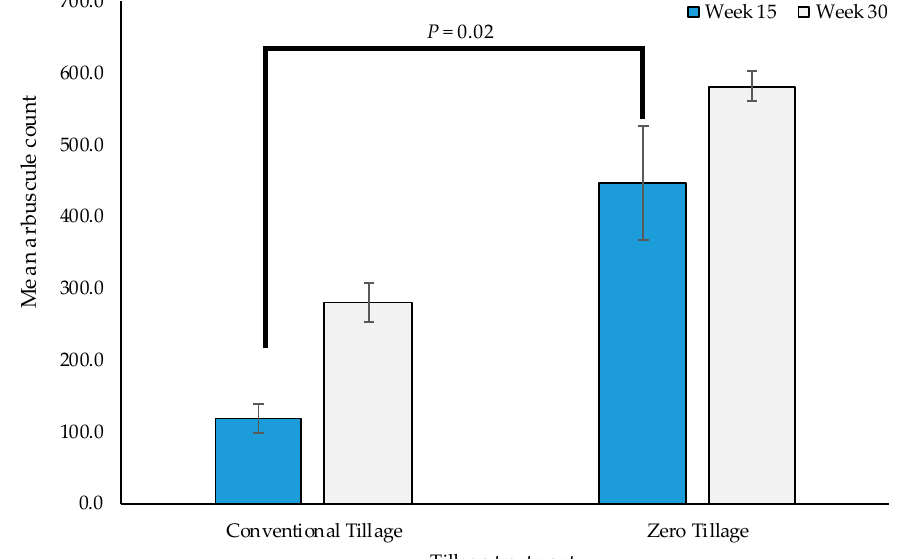
Figure 4. Average ( n = 20 per sampling period per tillage treatment) stained intracellular AM fungal arbuscules from glasshouse grown winter wheat after 15 and 30 weeks. Multi-way ANOVA ( F = 51.123,3 y = 19; P = 1.17 × 10 − 6 ). Error bars = one SEM.